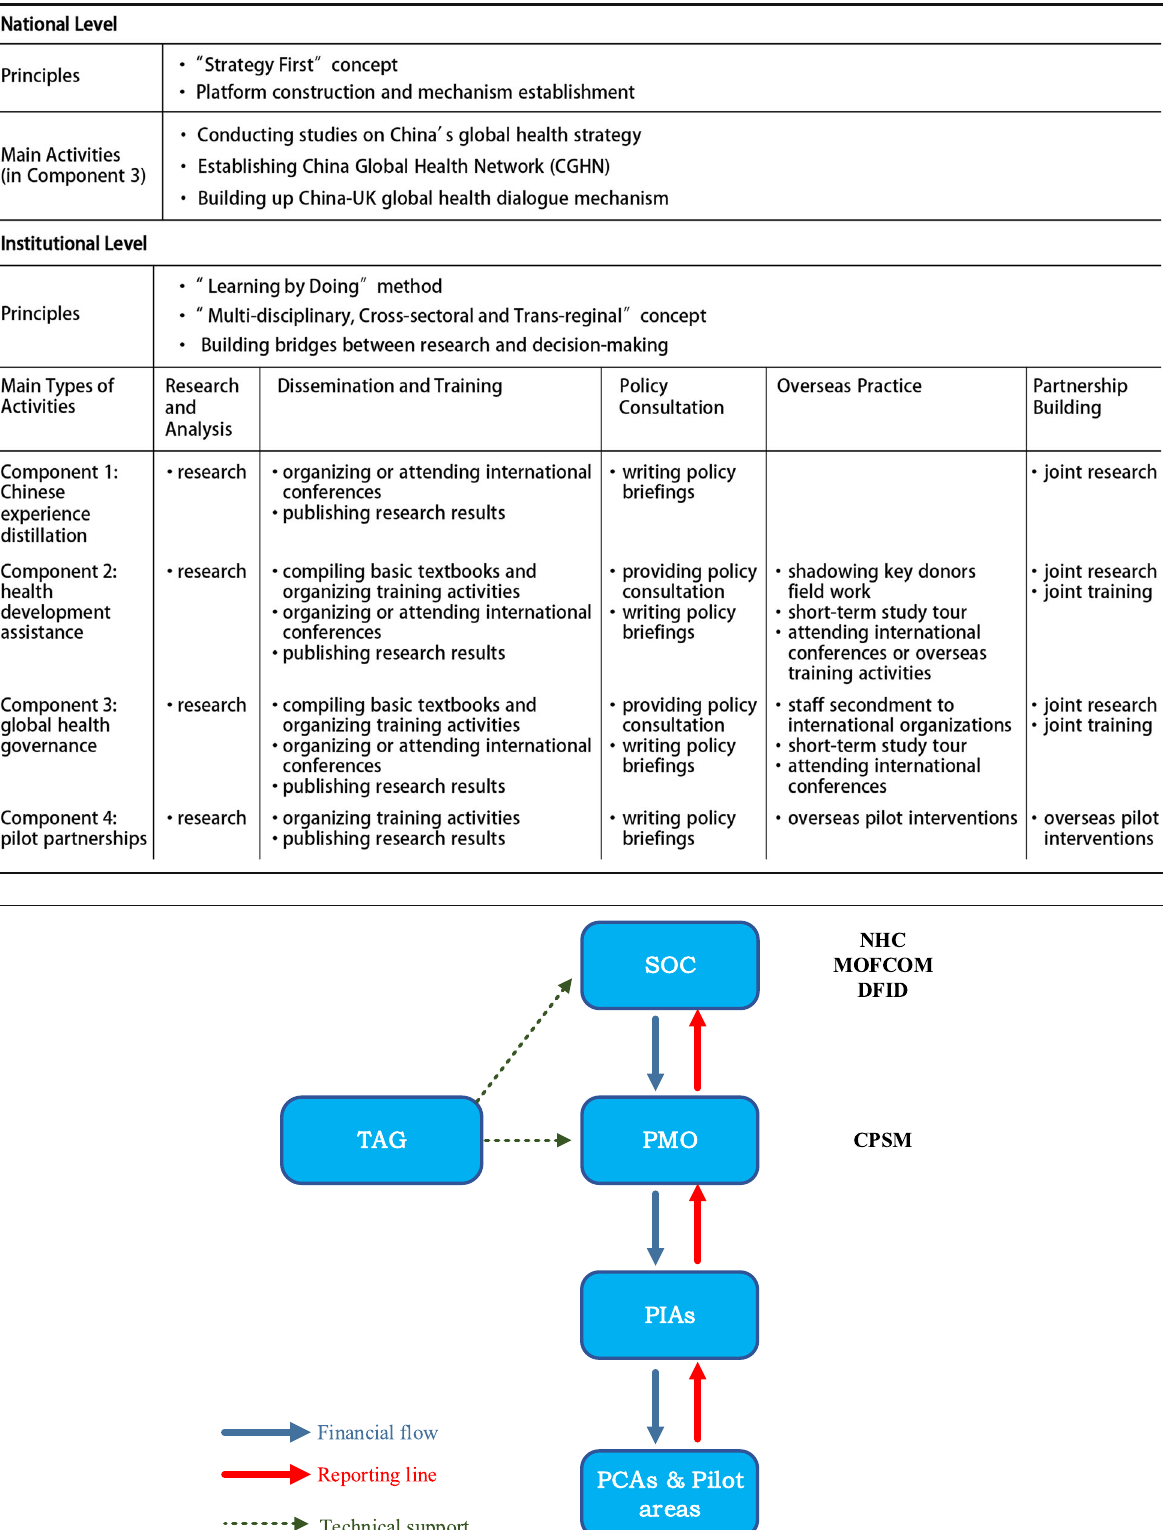
Fig. 2 Organizational structure of the